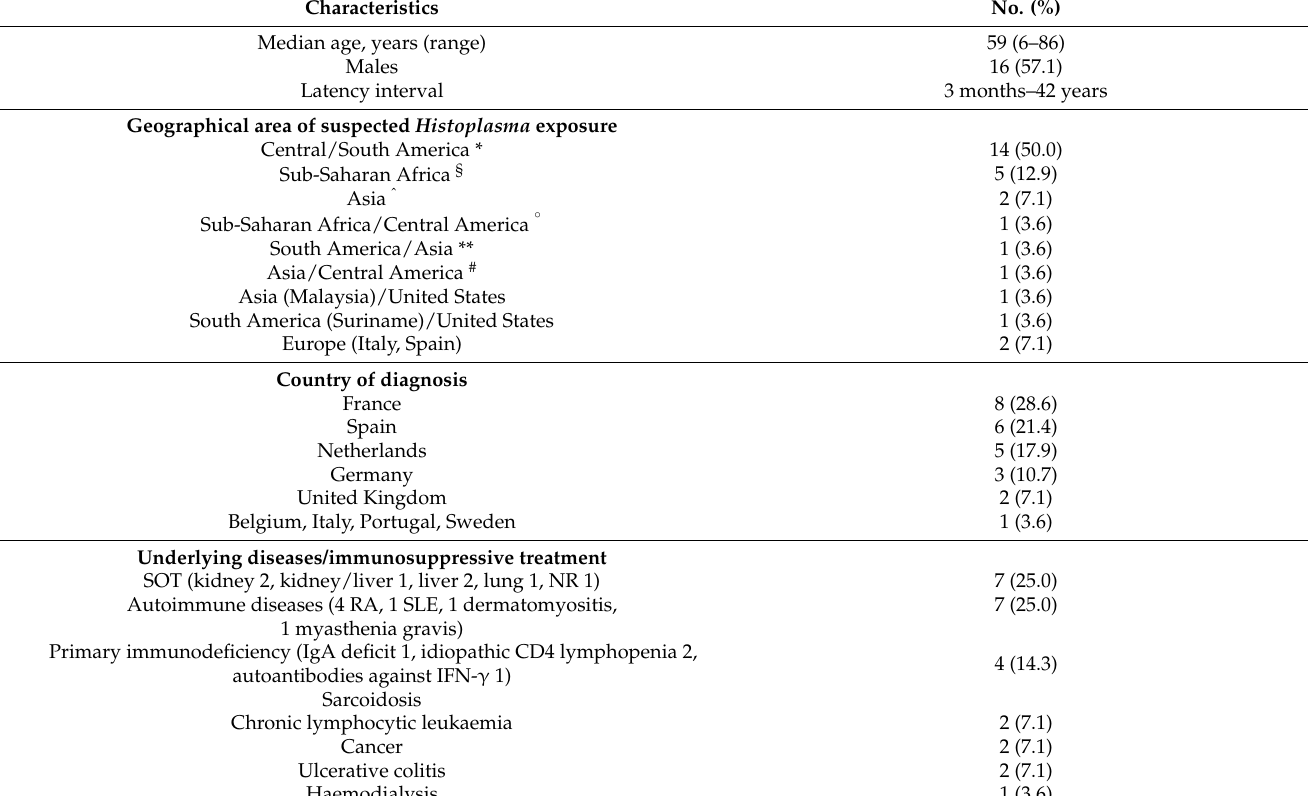
Table 4. Characteristics of 28 immunocompromised HIV-negative patients diagnosed as having histoplasmosis in